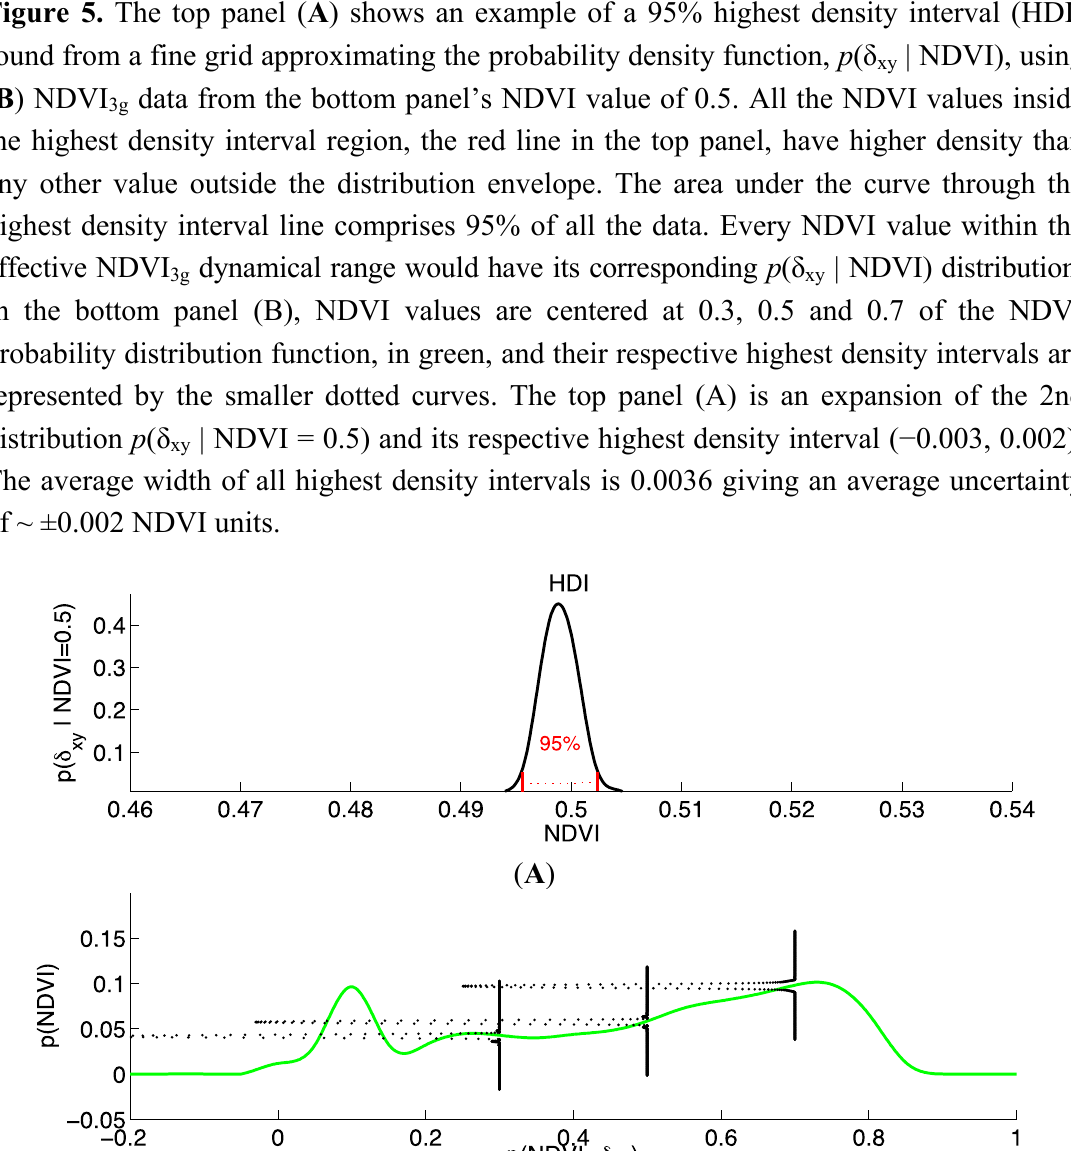
| NDVI), using xy | NDVI) distribution. xy